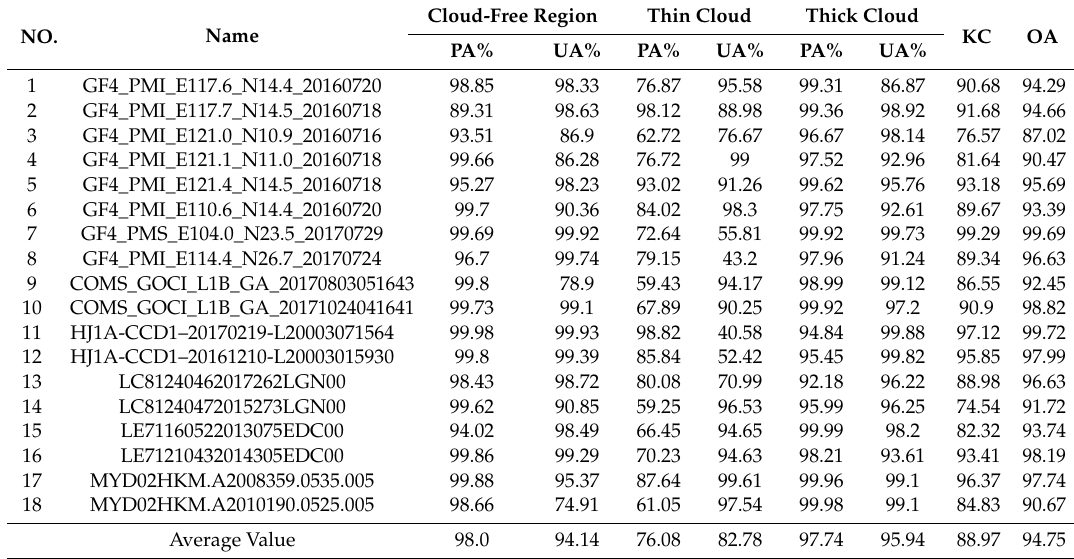
Table 4. Cloud detection accuracy for the study area data. The accuracy assessment metric comprised overall accuracy (OA), Kappa Coe ffi cient (KC), User’s accuracy (UA), Producer’s accuracy (PA), and class-specific accuracy